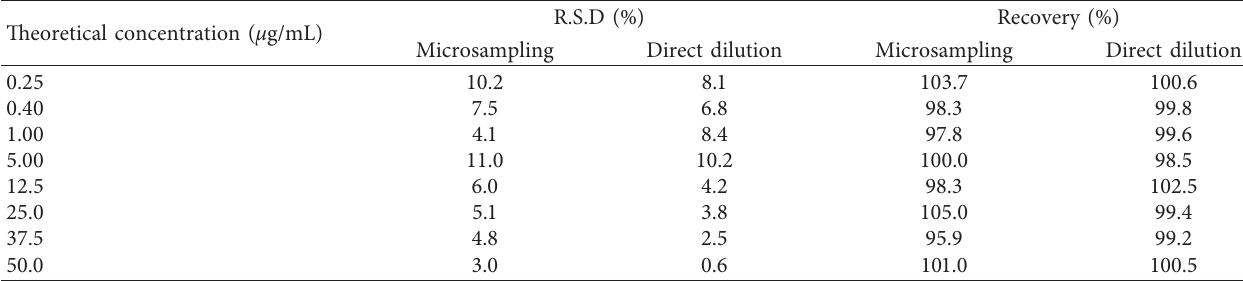
Figure 1: Overlay of typical multiple reactions monitoring mode chromatograms for tetracycline (a) and doxycycline (b) obtained from blank human urine (red line) and urine spiked with the LLOQ concentration (blue line) after extraction of the microsampling device. Table 2: Relative standard deviation and recovery from back-calculated concentrations from calibration curves after microsampling and direct dilution ( n � 6